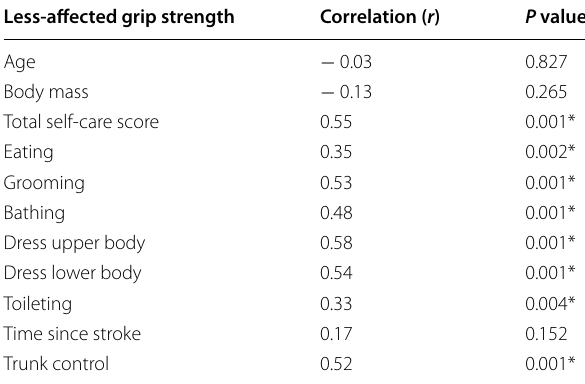
Table 2 Association of less-affected grip strength with self-care activities and clinical